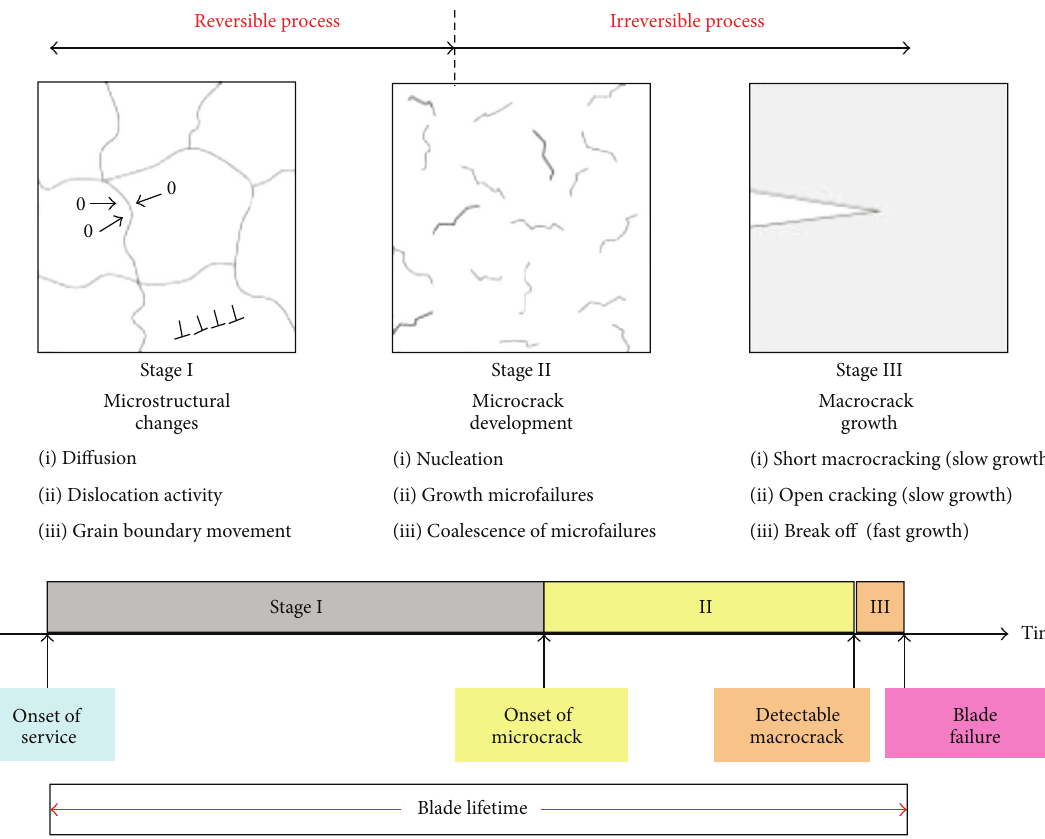
Figure 5: Continuum damage mechanics for compressor blade material. The first stage and the beginning of the second stage of damage are copying reversible changes [3].